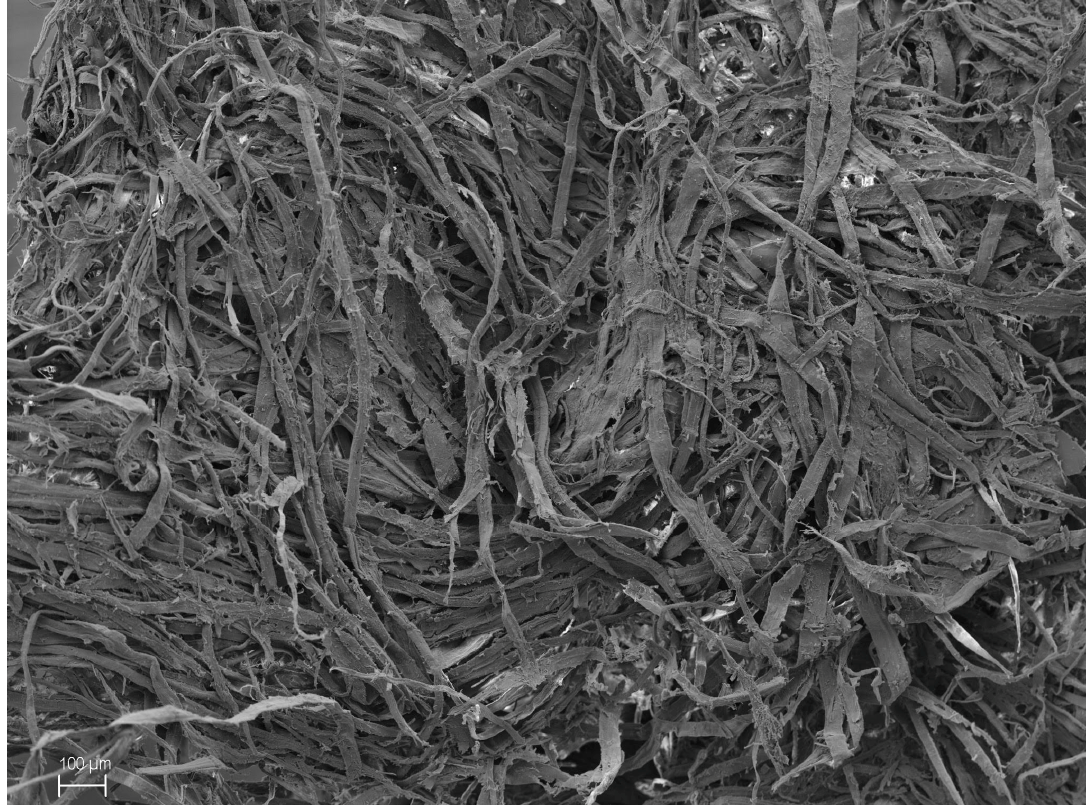
Figure 2. Image of the cellulose fibers of the paper industry obtained with the scanning electron microscope in the secondary option.